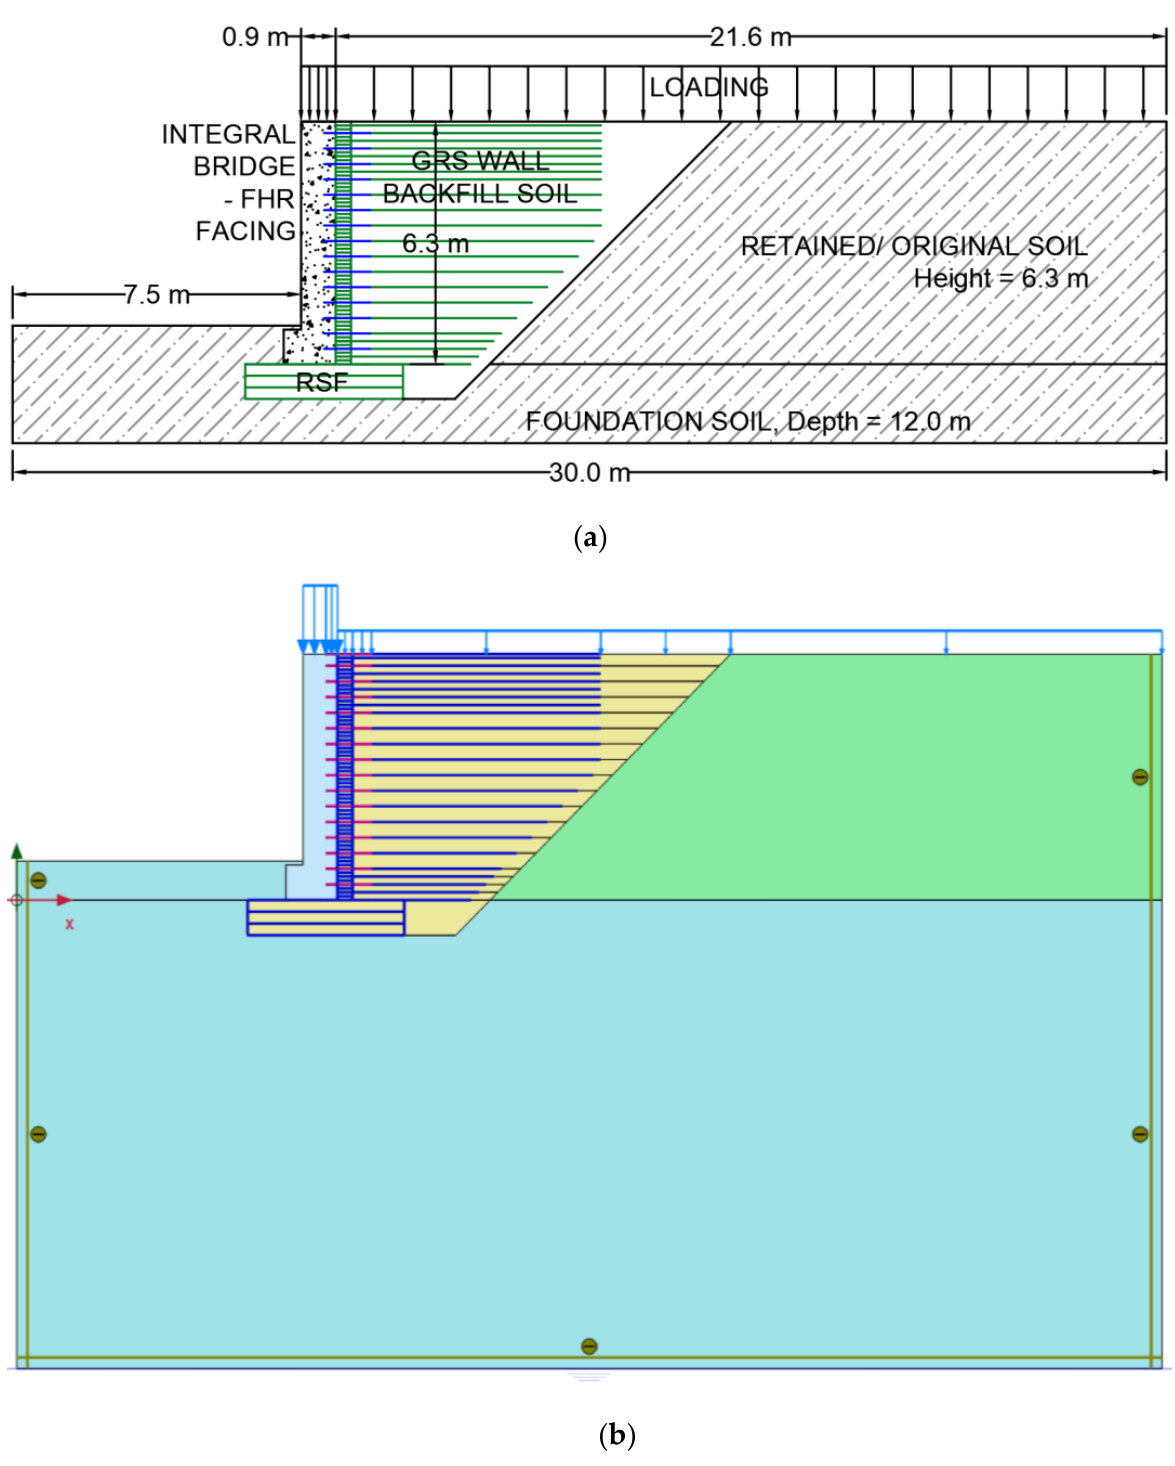
Figure 1. Design and Plaxis 2D Numerical Model for GRS-IB (Case 1). ( a ) Model Design for GRS-IB. ( b ) Plaxis 2D Numerical Model for GRS-IB.